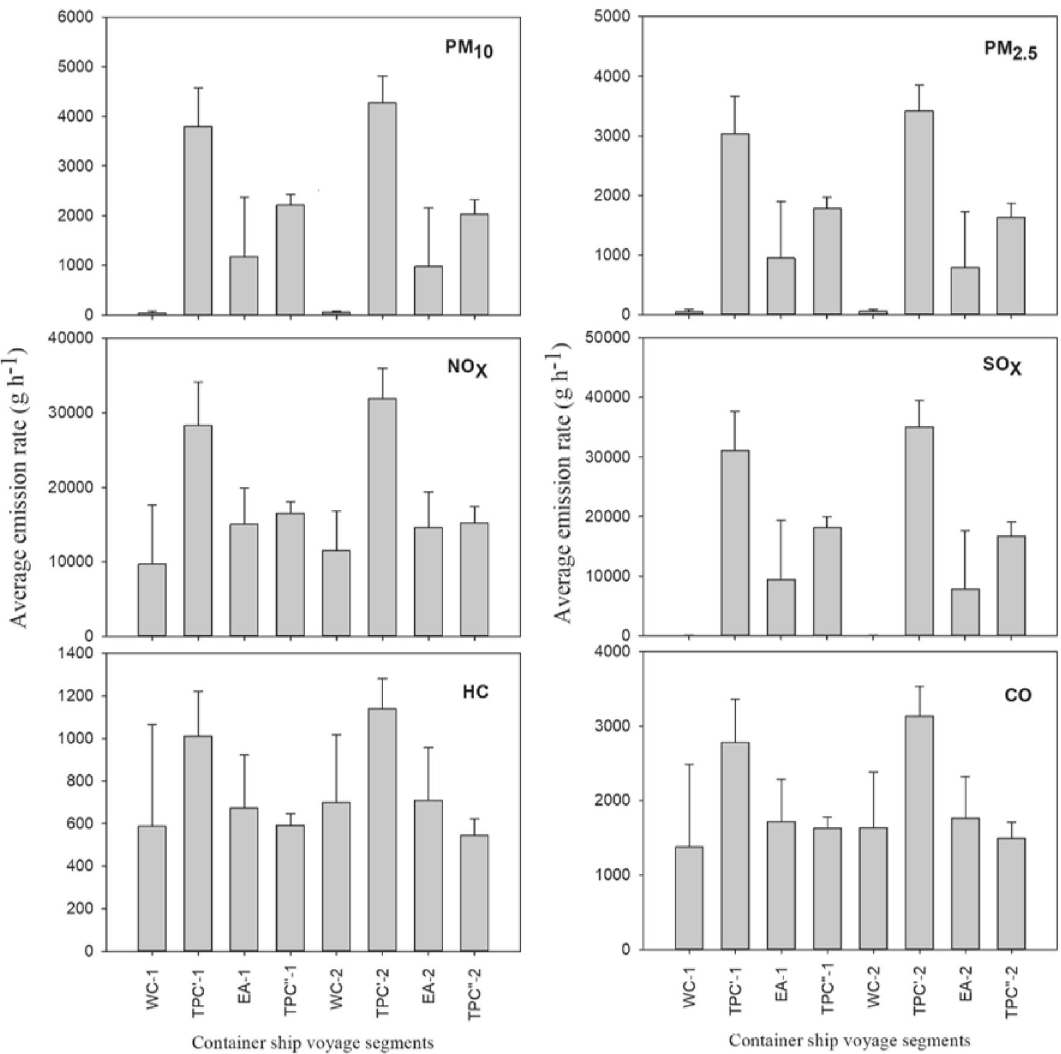
Figure 3. The estimated emission rates of the air pollutants from the container ship at the different voyage segments. WC west coast of the US, TPC ′ transpacific crossing to the East Asian ports, EA East Asia, TPC ″ transpacific crossing heading back to the Port of Los Angeles.